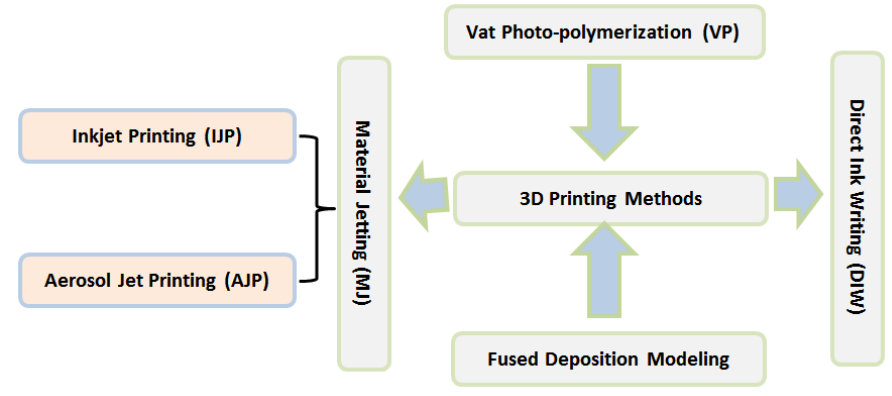
Figure 7. The common 3D printing processes for the ceramic devices [102–104].